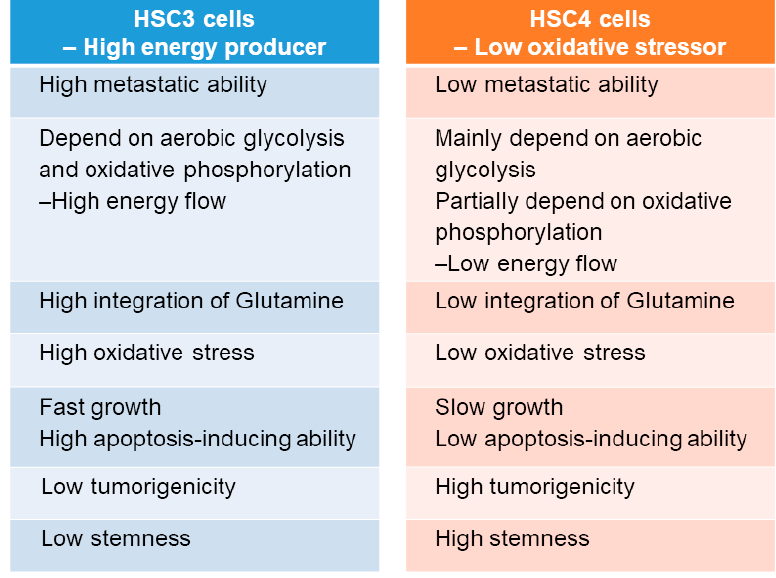
Figure 6. Characteristics of HSC3 and HSC4 cells.